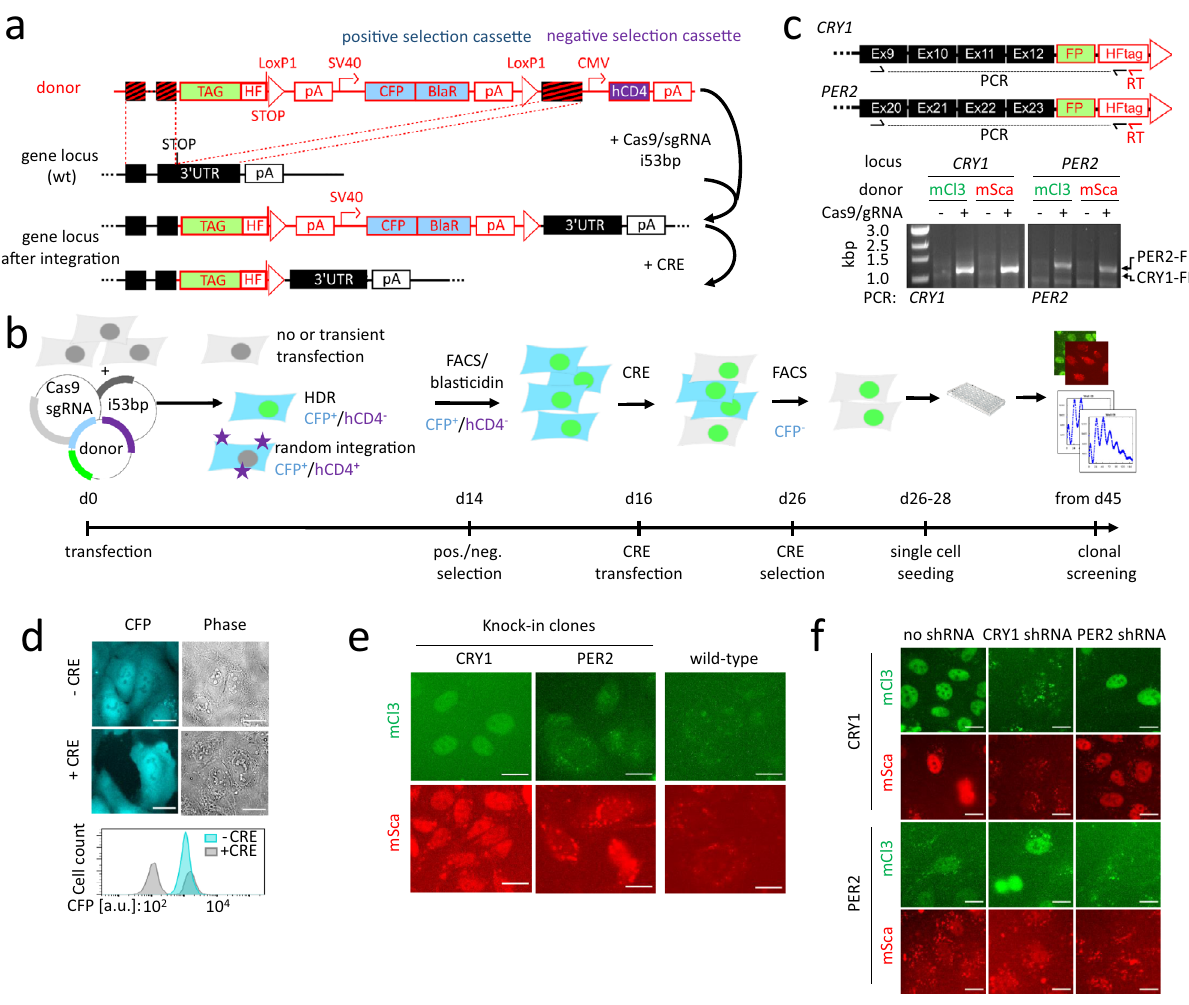
Fig. 1 CRISPR/Cas9-mediated generation of clock protein knock-in reporter cells. a Donor plasmid design and genome editing strategy: The tag (e.g. fl uorescent protein) to be integrated and a fl oxed positive selection cassette (cyan fl uorescent protein (CFP) + blasticidin-resistance (BlaR)) are fl anked by arms, which are homologous to the genomic target region. When Cas9/single guide RNA(sgRNA)-mediated DNA double strand breaks are repaired by HDR, tag, and positive selection marker are integrated into the target region. The negative selection cassette (hCD4, a cell surface protein exclusively expressed on immune cells) is only integrated into the genome by unwanted random integration of the whole donor plasmid. b Selection strategy. Cells are transfected with Cas9, sgRNA, i53bp (see text), and donor plasmid. Stable transfectants are selected by blasticidin selection and fl uorescence-activated cell sorting (FACS) of CFP positive cells (blue), while unwanted hCD4 positive cells (purple stars) are depleted. Subsequently, cells are transiently transfected with Cre recombinase (CRE) to remove the positive selection cassette from the genomic locus, and only CFP negative cells (gray) are clonally expanded and screened for successful knock-in. c Chimeric mRNA was detected in selected batch cultures by reverse transcription-polymerase chain reaction (RT-PCR) using a RT- and a reverse primer speci fi c to the insertion and a gene-speci fi c forward primer. d Loss of CFP expression after removal of the positive selection cassette monitored by microscopy and fl ow cytometry. The gating strategy used FSC and SSC signals to gate out doublets and debris. e Fluorescence microscopy images of successful knock-in clones. f Indicated knock-in cells were either left untreated or transduced with shRNA targeting either CRY1 or PER2 . Images were acquired 10 h after synchronization. Corresponding differential interference contrast (DIC) images are shown in Supplementary Fig. 3a. Scale bars: 20 µ m. mCl3 mClover3, mSca mScarlet-I, FP fl uorescent protein, pA polyadenylation signal, SV40 simian virus-40 promoter, CMV cytomegalovirus promoter, HF His-tag/FLAG-tag, shRNA short hairpin RNA, UTR untranslated region, Ex exon, FSC forward scatter, SSC sideward scatter. Source data are provided as a Source Data fi codon sequence. The donor vector contained the coding sequence of mScarlet-I fl anked by PER2 sequences (~800 bp) homologous to those directly upstream and downstream of the STOP codon. A C- terminal 6xHis/FLAG-tag (HF-tag) and a new STOP codon for the fusion protein followed downstream of mScarlet-I (Fig. 1a).